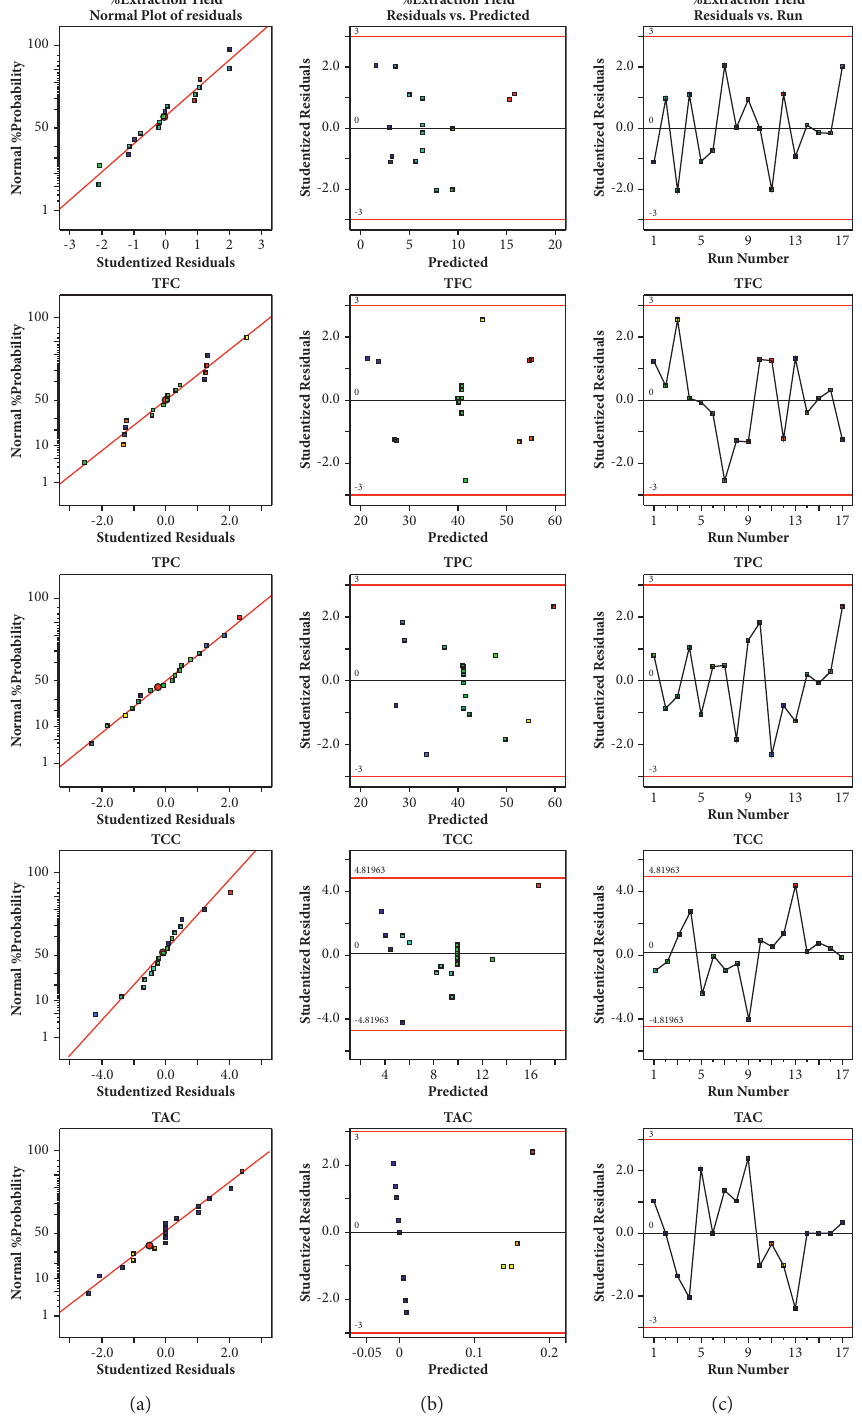
Figure 2: Diagnostic plot for model adequate checking of percentage extraction yield (%), TPC, TFC, TCC, and TAC: (a) normal % probability against internally studentized residuals, (b) internally studentized residuals against predicted, and (c) internally studentized residuals against run